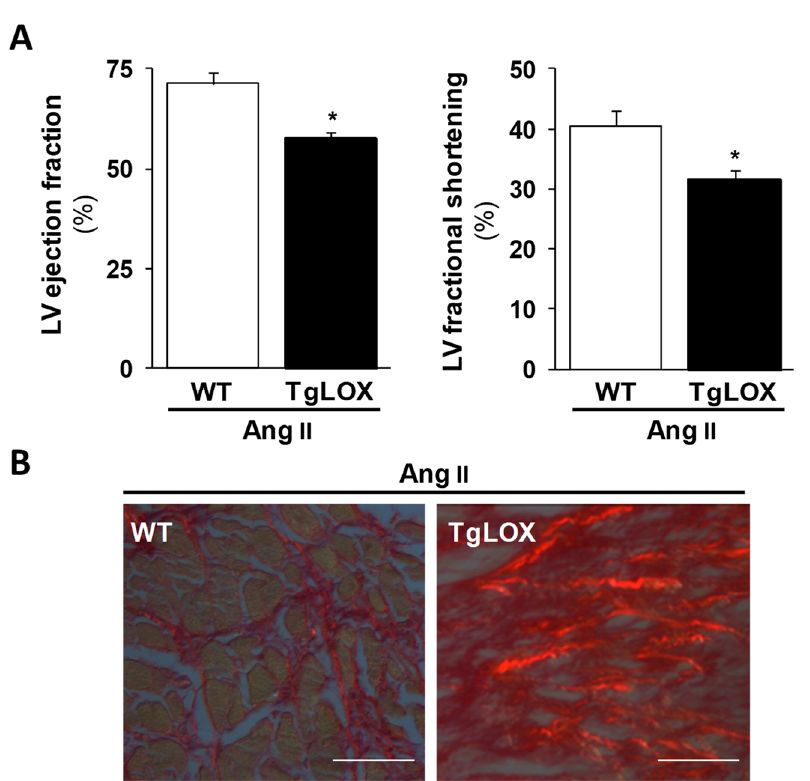
Figure 5. LOX transgenesis exacerbates Ang II-induced LV systolic dysfunction and fibrosis. ( A ) WT (white columns) and TgLOX (black colums) mice were infused with AngII (1000 ng/kg/min) or saline solution for 14 days. The overexpression of LOX reduces left ventricular (LV) ejection fraction (left panel) and fractional shortening (right panel) as determined by echocardiography in Ang II infused mice. Results are expressed as mean ± SD. * p < 0.05 vs. WT. ( B ) Heart sections from Ang II-infused mice were stained with Picrosirius red. Under polarized light, cross-linked collagen appears as red refringent fibers. As shown, LOX overexpression enhances the Ang II-induced deposition of mature collagen (Bar: 50 µm).